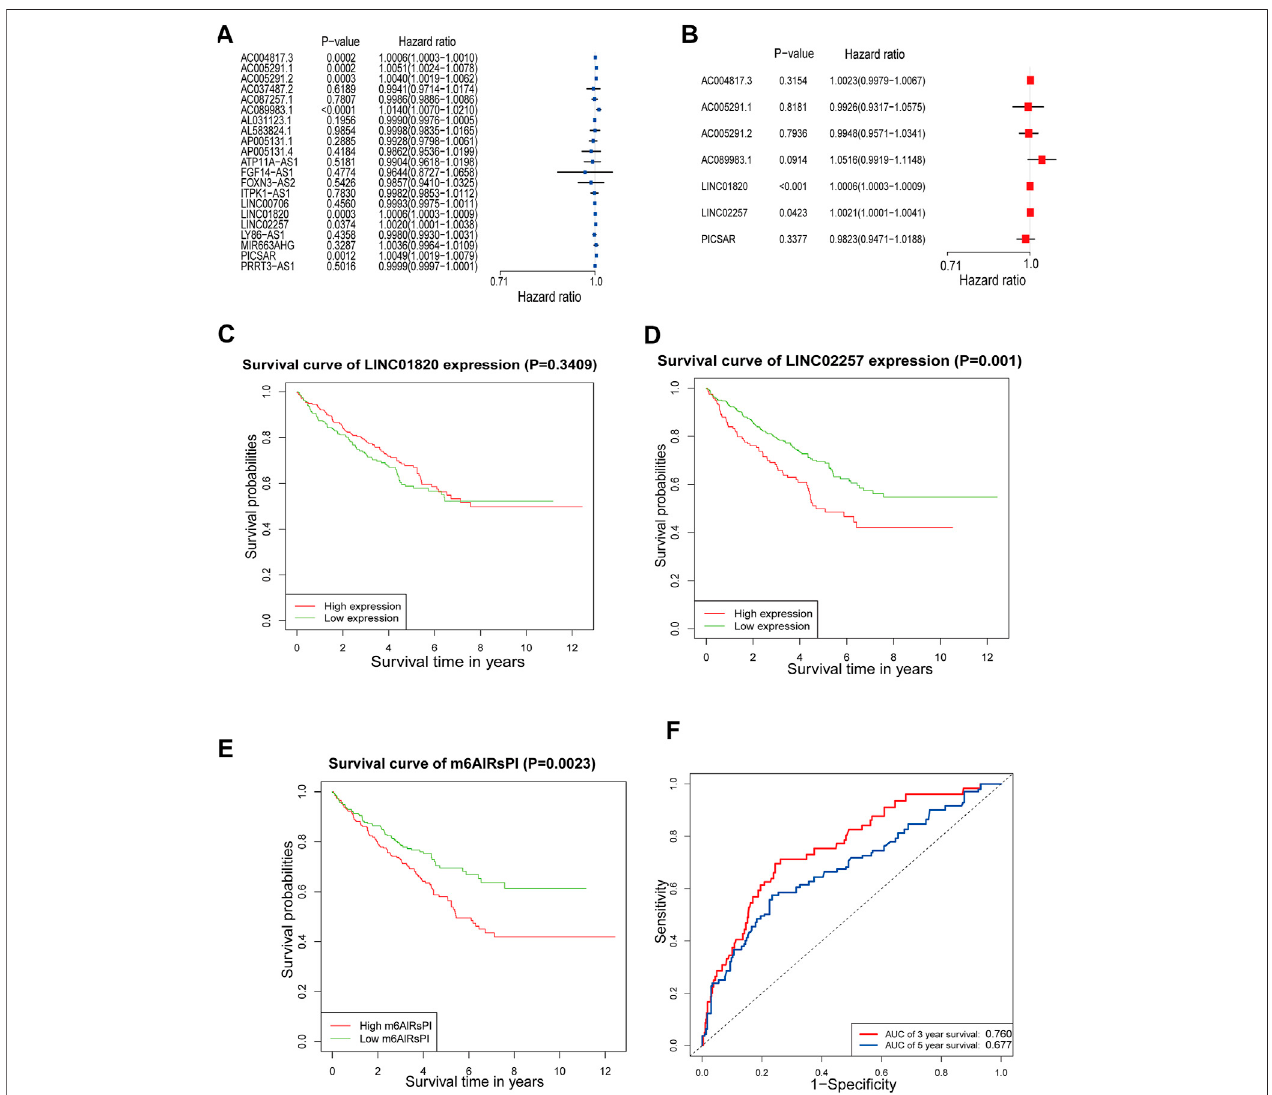
FIGURE 4 | Cox regression analysis and survival analysis. (A) The result of univariate Cox regression analysis for m6A-lncRNAs in red and turquoise modules shown by forest plot. (B) The outcome of multivariate Cox regression analysis for m6A-lncRNAs with p < 0.05 in univariate analysis. (C – E) Survival analysis for LINC01820, LINC02257, and m6AlRsPI in the training cohort (F) ROC curve for m6AlRsPI for predicting 3- and 5-year survival. The red curve means 3-year survival prediction, with the area under the curve of 0.760. The blue curve means 5-year survival prediction, with the area under the curve of 0.677.